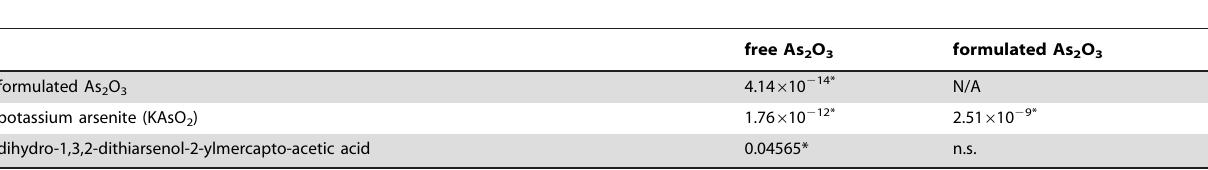
Table 1. Cross-resistance between arsenic trioxide and other arsenic compounds in the NCI cell line